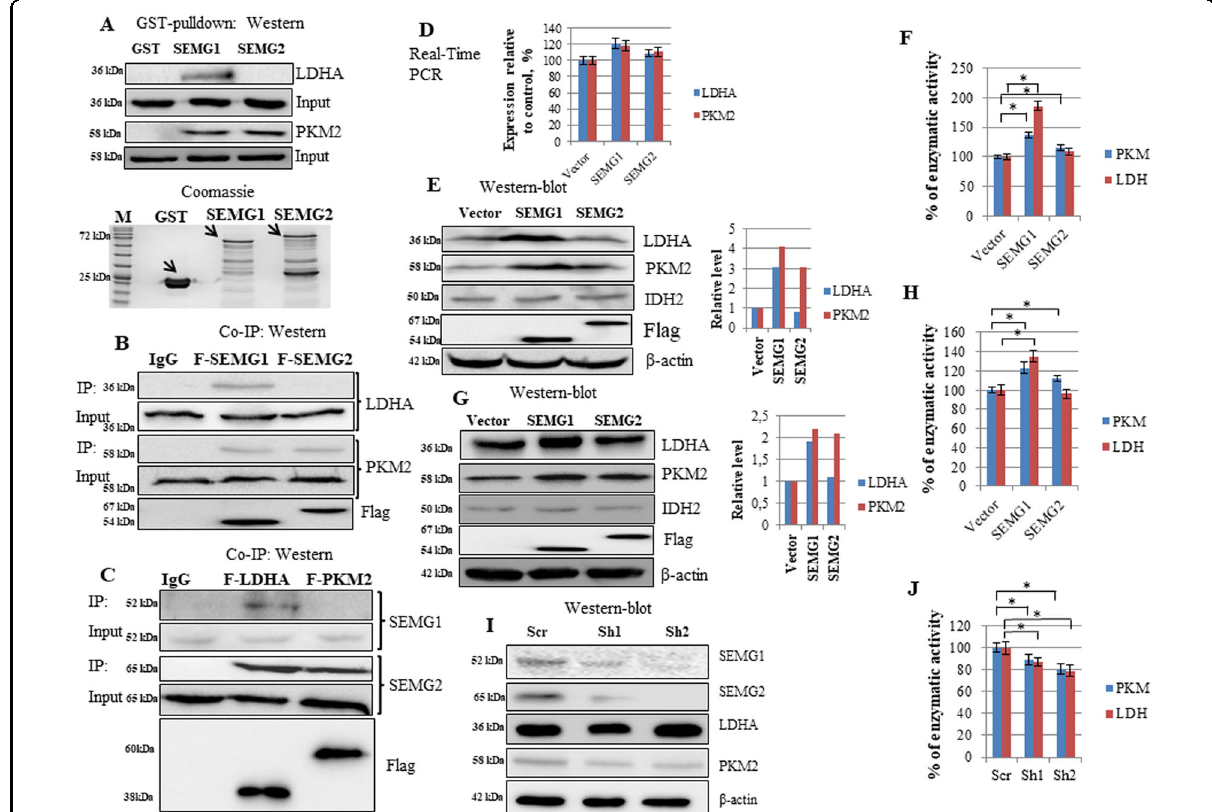
Fig. 4 SEMG1 and SEMG2 interact with PKM2 and LDHA, upregulates their protein level and enzymatic activity. Recombinant SEMG1 and SEMG2 bind PKM2, whereas SEMG1 only binds LDHA in GST pull-down assay followed by western-blotting. B 3×Flag-tagged SEMG1 and SEMG2 bind PKM2, whereas SEMG1 only binds LDHA in co-immunoprecipitation. C 3×Flag-tagged PKM2 interacts with both endogenous SEMG1 and SEMG2 in H520 cells, whereas 3xFlag-tagged LDHA binds SEMG1 only (co-immunoprecipitation). D Overexpression of SEMG1 and SEMG2 in H1299 cell line does not alters the mRNA levels of PKM2 and LDHA (Real-Time PCR). The stable overexpression of SEMG1 and SEMG2 increase the protein level and enzymatic activity of PKM2, whereas the overexpression of SEMG1 only elevates the protein level and enzymatic activity of LDHA in E , F H1299 cells and G , H Mia-Paca 2 cells. Knockdown of SEMG1 and SEMG2 in H520 cells decreases the protein level ( I ) and enzymatic activity ( J ) of PKM2 and LDHA. Three biological replicates were used for all quanti fi cations, data are presented as mean ± S.D., * P <